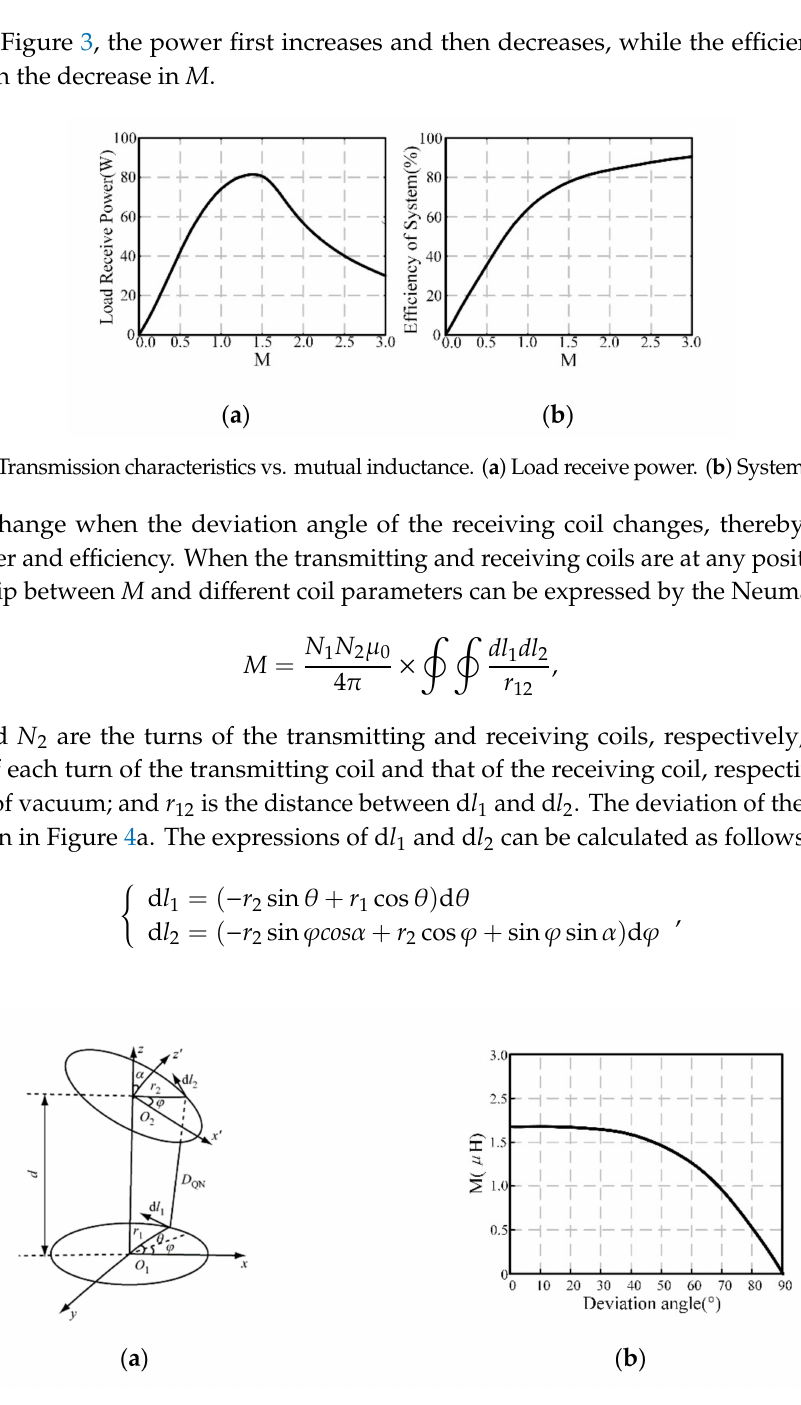
Figure 4. ( a ) Model of angular deviation. ( b ) Mutual inductance vs. deviation